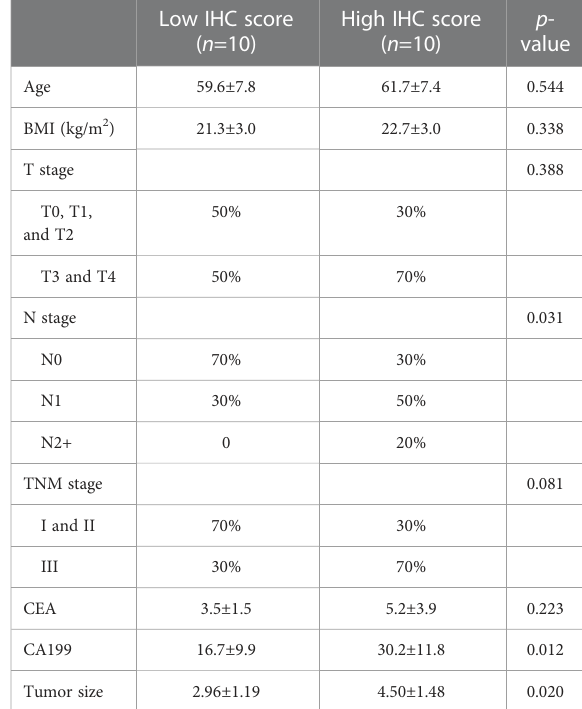
TABLE 1 Clinical